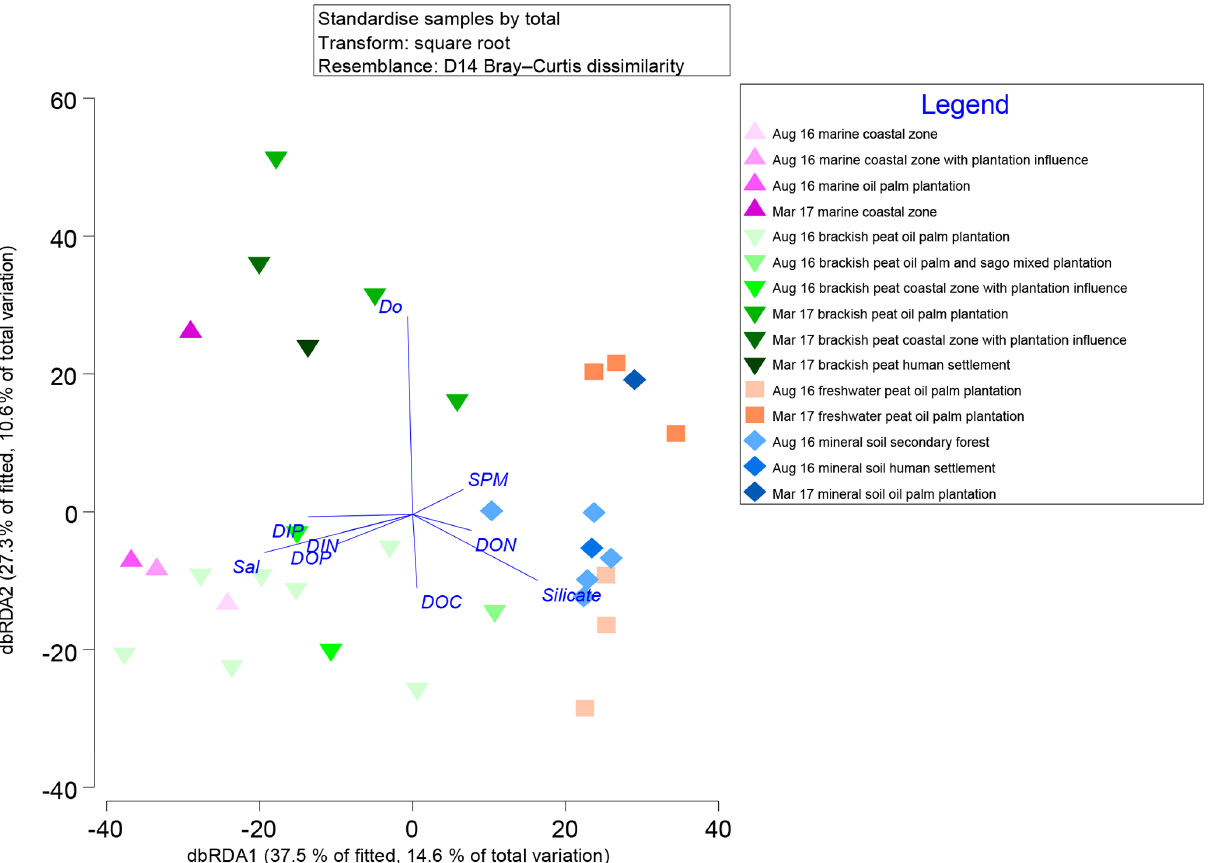
Figure 7. Distance-based redundancy analysis (dbRDA) plot of cruise, source type and land use on a linear model (DistLM) of normalised predictor